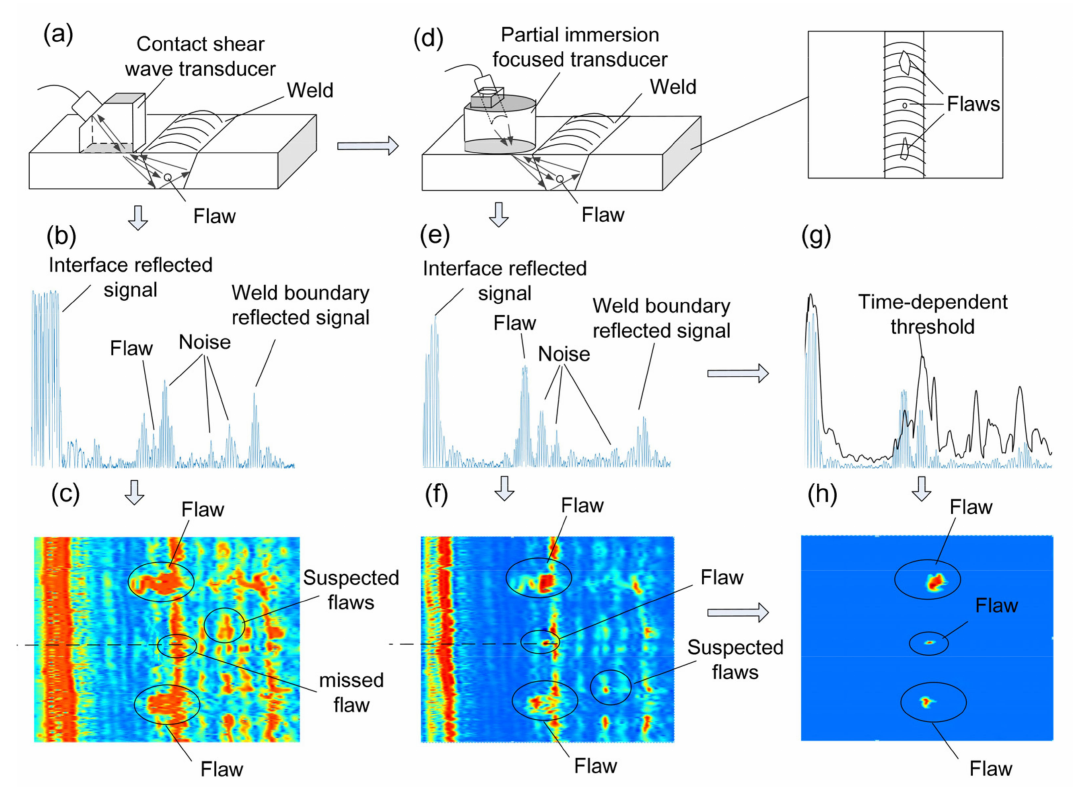
Figure 1. Schematic diagram of weld inspection. ( a ) traditional contact ultrasonic detection, ( b ) typical ultrasonic wave signal, ( c ) imaging result using contact detection method, ( d ) proposed partial immersion focused ultrasonic detection, ( e ) enhanced ultrasonic wave signal, ( f ) imaging